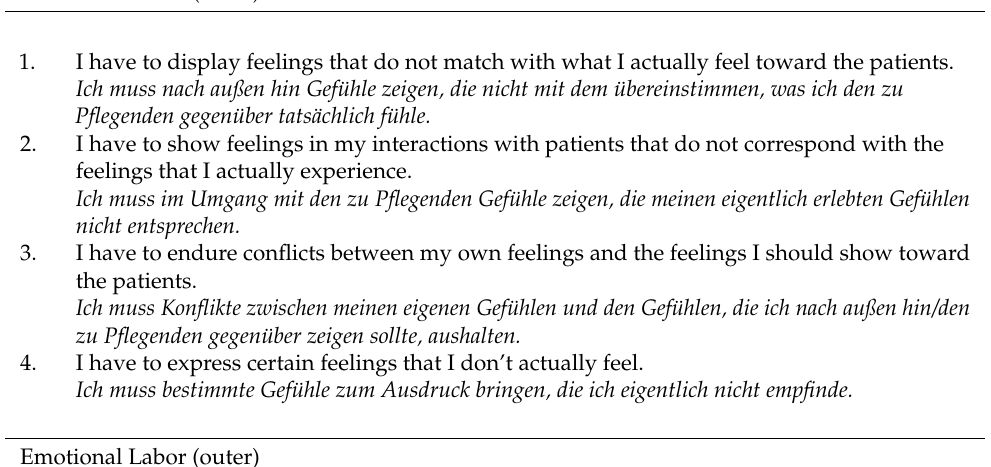
Table A1. English and German Items of the IWDS-N. Emotional Labor